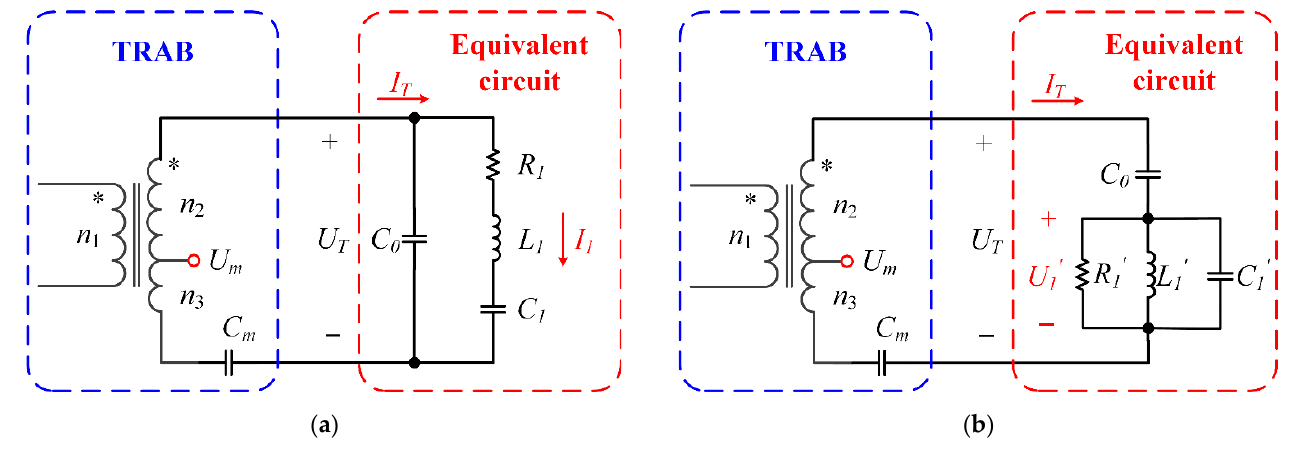
Figure 5. Electromechanical model of the single-phase piezoelectric element of the USM and TRAB: ( a ) Equivalent circuit and TRAB; ( b ) transformation of the electromechanical model and TRAB. According to the principle of equivalent circuit and Kirchhoff’s law, the stator vibra- tion amplitude 𝑊 can be characterized by the partial voltage 𝑈 (cid:2869) (cid:4593) , which links the mechan-